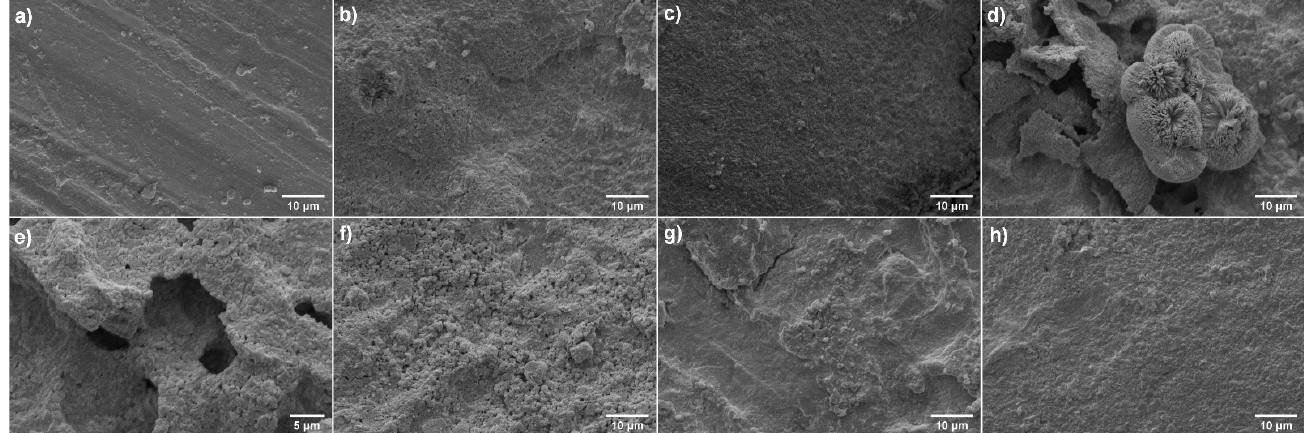
Table 1. Release of fluoride ions ( μ g/mm 2 /h) from composite Wave (W) into nine environments differing in composition of the solution and pH. Six samples were prepared for each solution. Descriptive data were presented as mean ± standard deviation (± SD). Time (Hours)